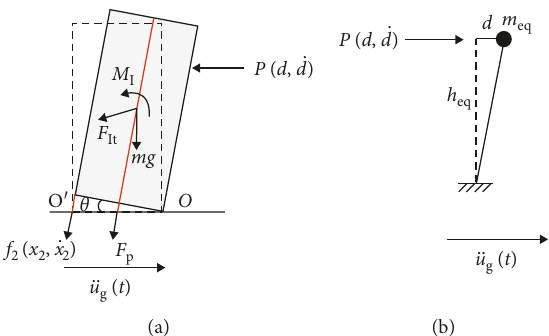
Figure 12: Mechanical analysis of the FSCW structure when the SC wall rotates about point O : (a) SC wall; (b) frame. ′